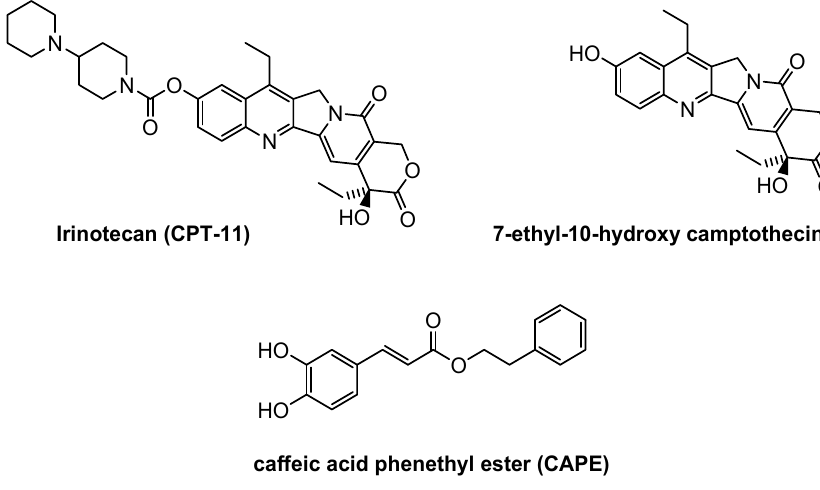
Figure 1. The structural formula of compounds studied in this work.